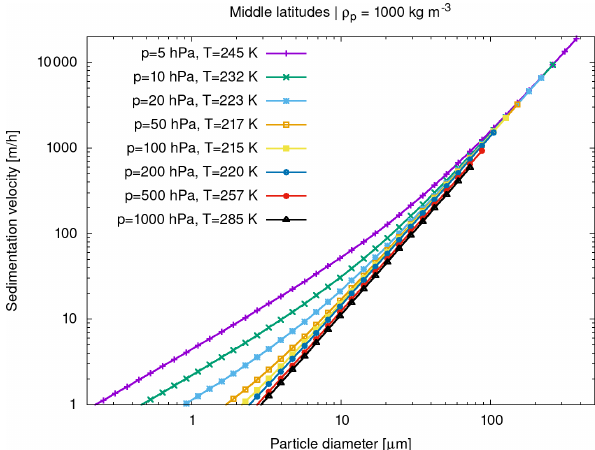
Figure 5. Sedimentation velocities of spherical particles in the Stokes–Cunningham regime for different particle sizes, atmo- spheric pressure levels, and midlatitude mean